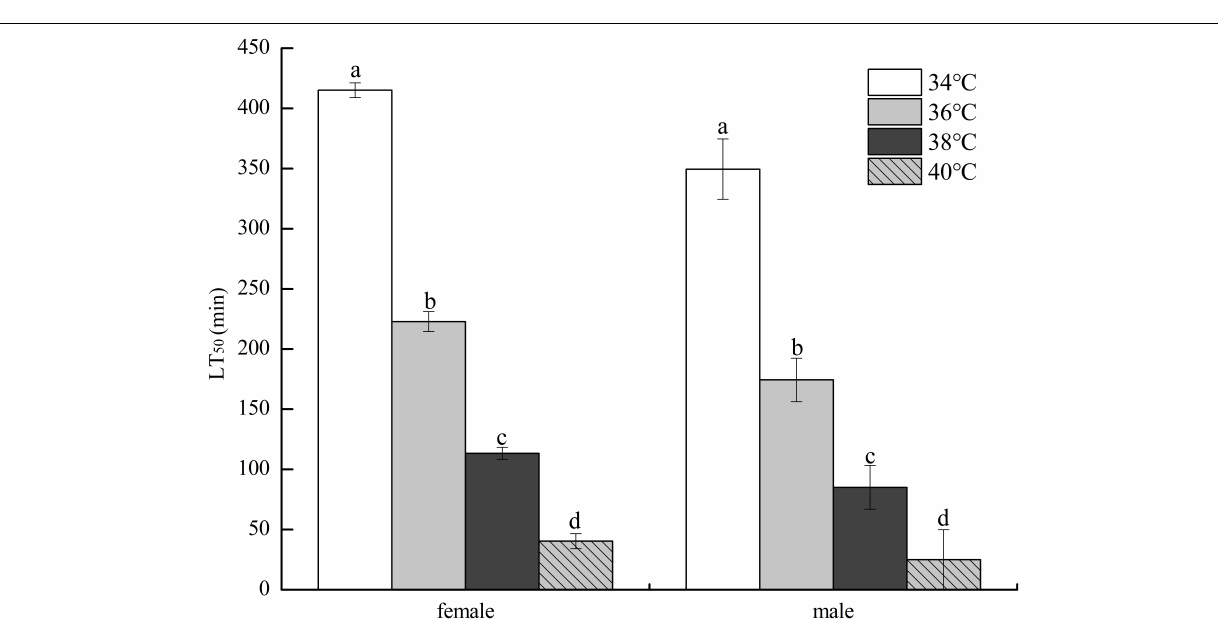
FIGURE 2 | The lethal time of 50% (LT 50 ) of fruit flies fed a diet containing hsian-tsao extract of medium mass concentration (4 g/L) under different heat exposure temperatures (34, 36, 38, and 40 ◦ C) (150 male or female flies per group, 50 per replicate). Data show mean ± standard deviation (SD). Different lowercase letters indicate significant differences between groups (Duncan test after two-way ANOVA, P <